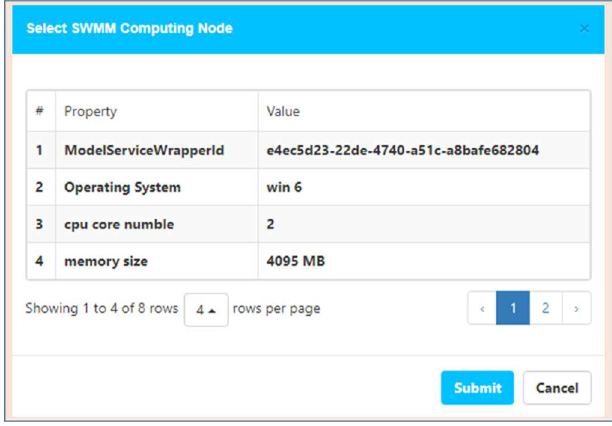
Figure 16. Select model service.